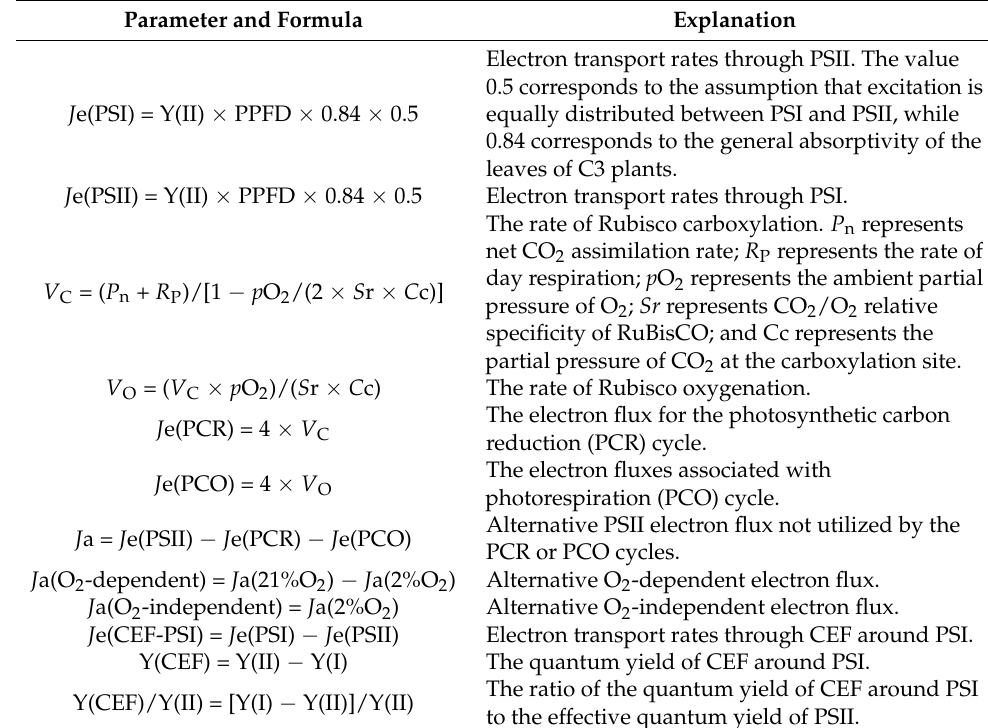
Table 2. Parameters of the linear electron flow (LEF) and cycle electron flux (CEF) transport rate. Parameter and